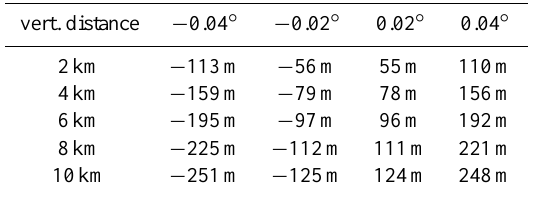
Table 3. Vertical shift of retrieved data for different elevation angle errors and altitudes below the observer.